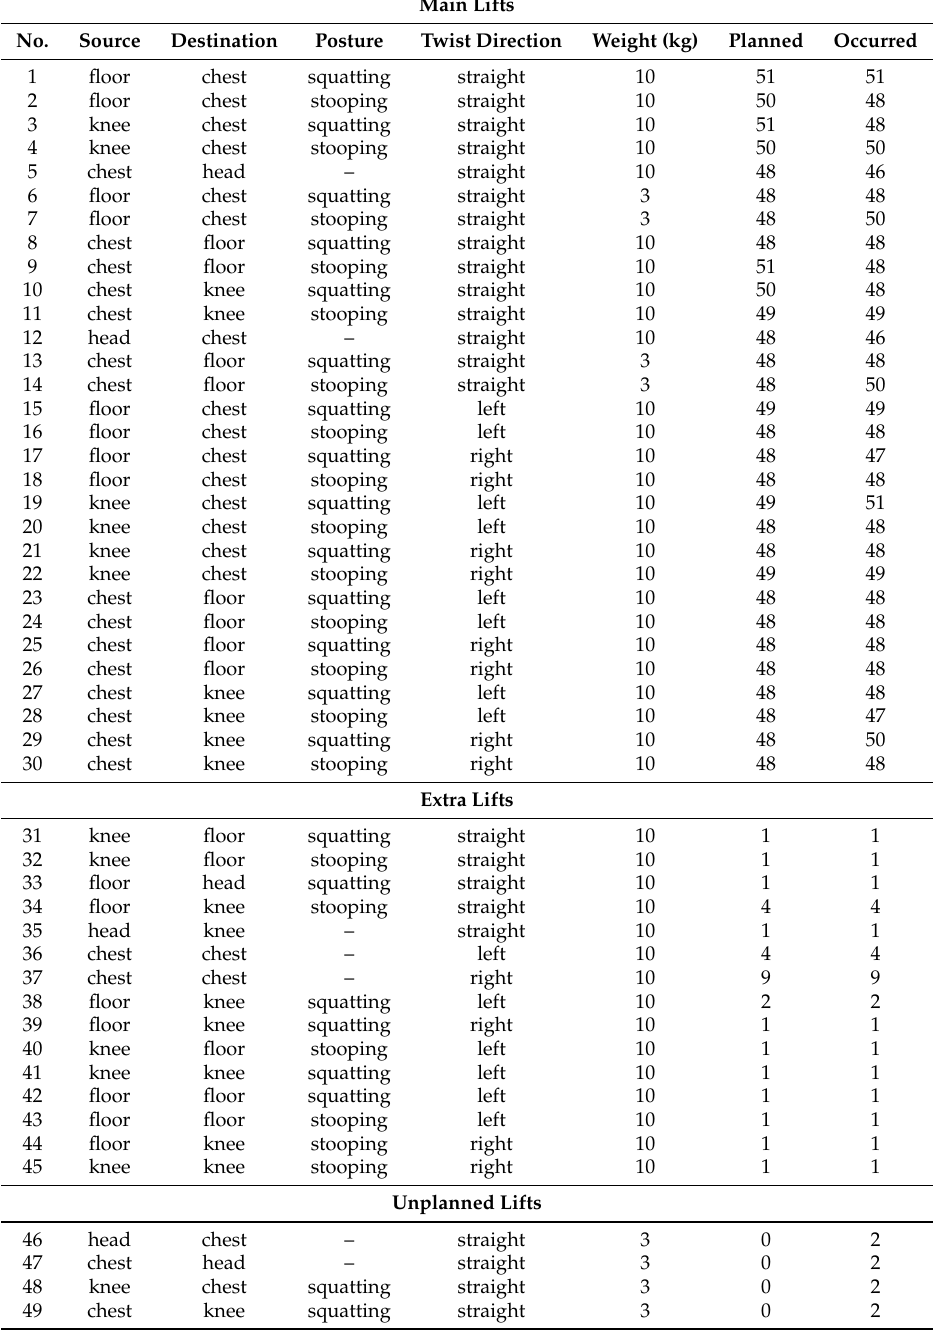
Table 2. All combinations of source, destination, posture, and twist direction that were used in the experiment, along with the number of each that were planned and that actually occurred throughout all 24 experiments. The table is organized by main lifts (the 30 main lifts that we were interested in), extra lifts (lifts designed specifically to serve as transition lifts), and unplanned lifts (lifts that were performed by mistake but do not necessarily hinder results). Though we required 48 occurrences of each of the main lifts (2 of each per participant), some were planned more times as transition lifts for some participants. The extra lifts were only performed when necessary as a transition between 2 main